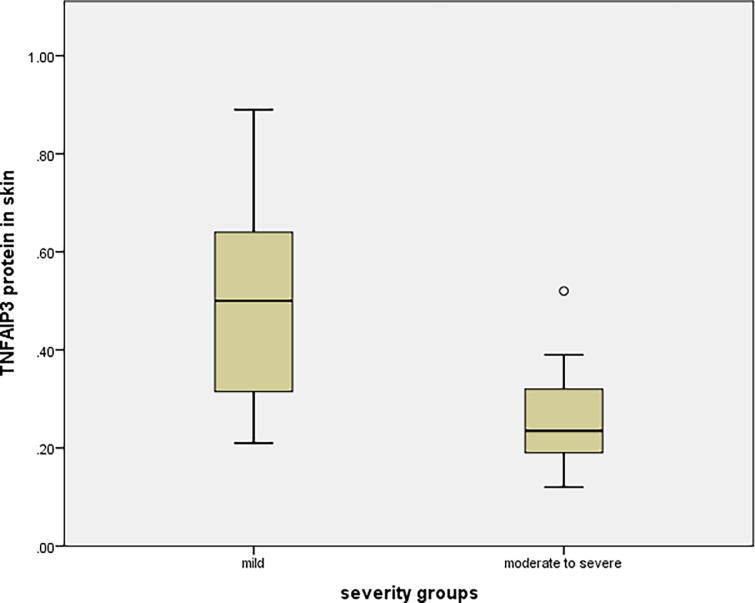
TNFAIP3 protein levels in psoriatic skin of mild and moderate/severe cases (P = 0.003).o = extreme case.